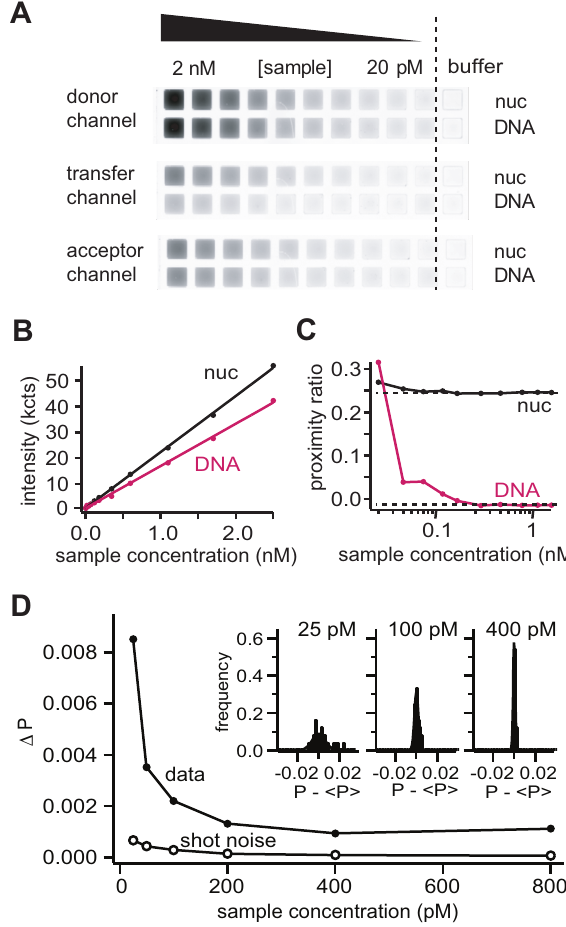
Figure 3. Characterization of microplate-scanning FRET spec- troscopy ( m psFRET). A) m psFRET grey scale images of a nucleosome sample (nuc) and a DNA fragment (DNA) at different sample concentrations (donor channel: excitation at 488 nm, detection at 500–540 nm; transfer channel: excitation at 488 nm, detection at 595– 625 nm; acceptor channel: excitation at 532 nm, detection at 595– 625 nm). Due to the absence of FRET, the DNA sample has a lower signal in the transfer channel. Concentrations are (from left to right): 2.5 nM, 1.7 nM, 1.1 nM, 600 pM, 350 pM, 180 pM, 120 pM, 70 p M, 40 pM, 20 pM, The last row to the right contained pure buffer